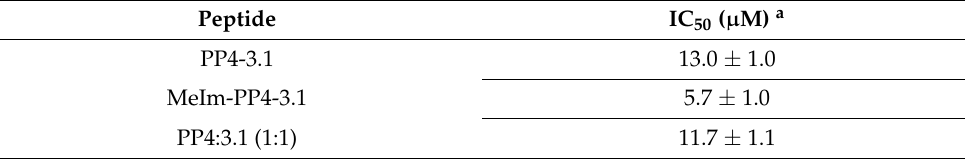
Table 4. Toxicity of test peptide constructs to HaCaT cells, after 24 h of incubation. Peptide